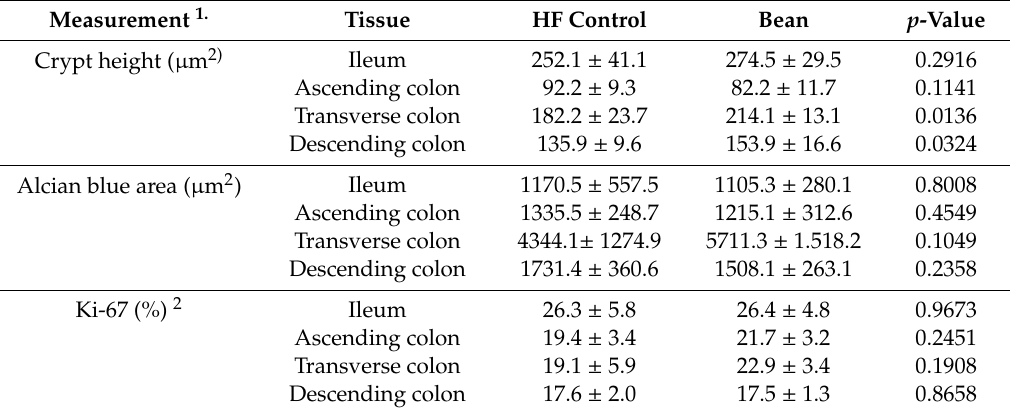
Table 5. E ff ect of feeding of white kidney bean on intestinal morphometry (Experiment 2). Measurement